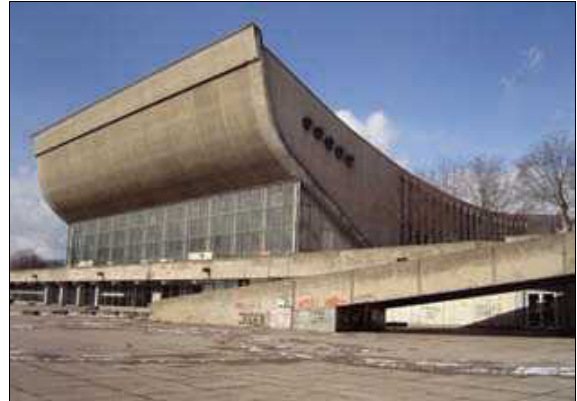
Fig. 21. Palace of Sports and cu­ltu­re in Vilniu­s